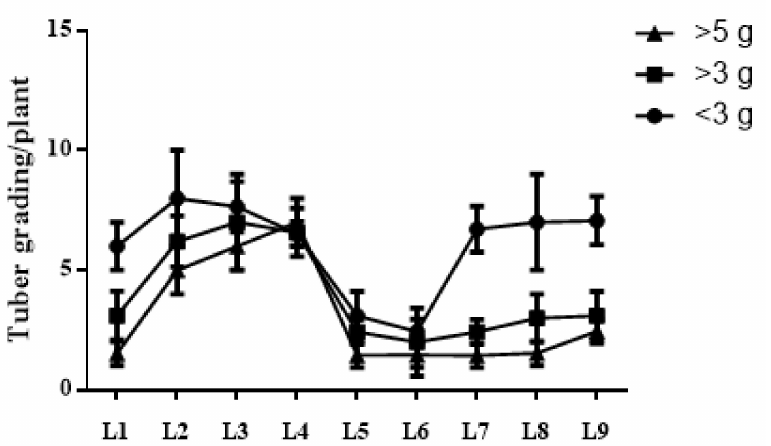
Figure 3. Effect of different LED light pre-treatment on potato tuber grading in the aeroponic system. Different letters indicate significant differences ( p ≤ 0.05) among the treatments within each parameter. Each value represents the mean ± SD (n = 3). L1 = natural light, L2 = R:B, L3 = R:B:G, L4 = R:B:FR, L5 = R:B:G:FR, L6= R:B:G:FR:UV, L7 = R:B:FR:UV, L8 = R:B:W:FR, L9 =